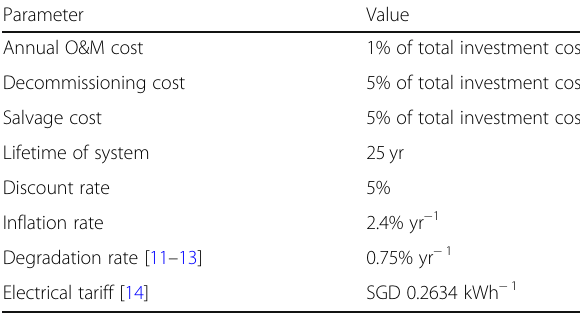
Table 3 Typical values of different parameters used in economic